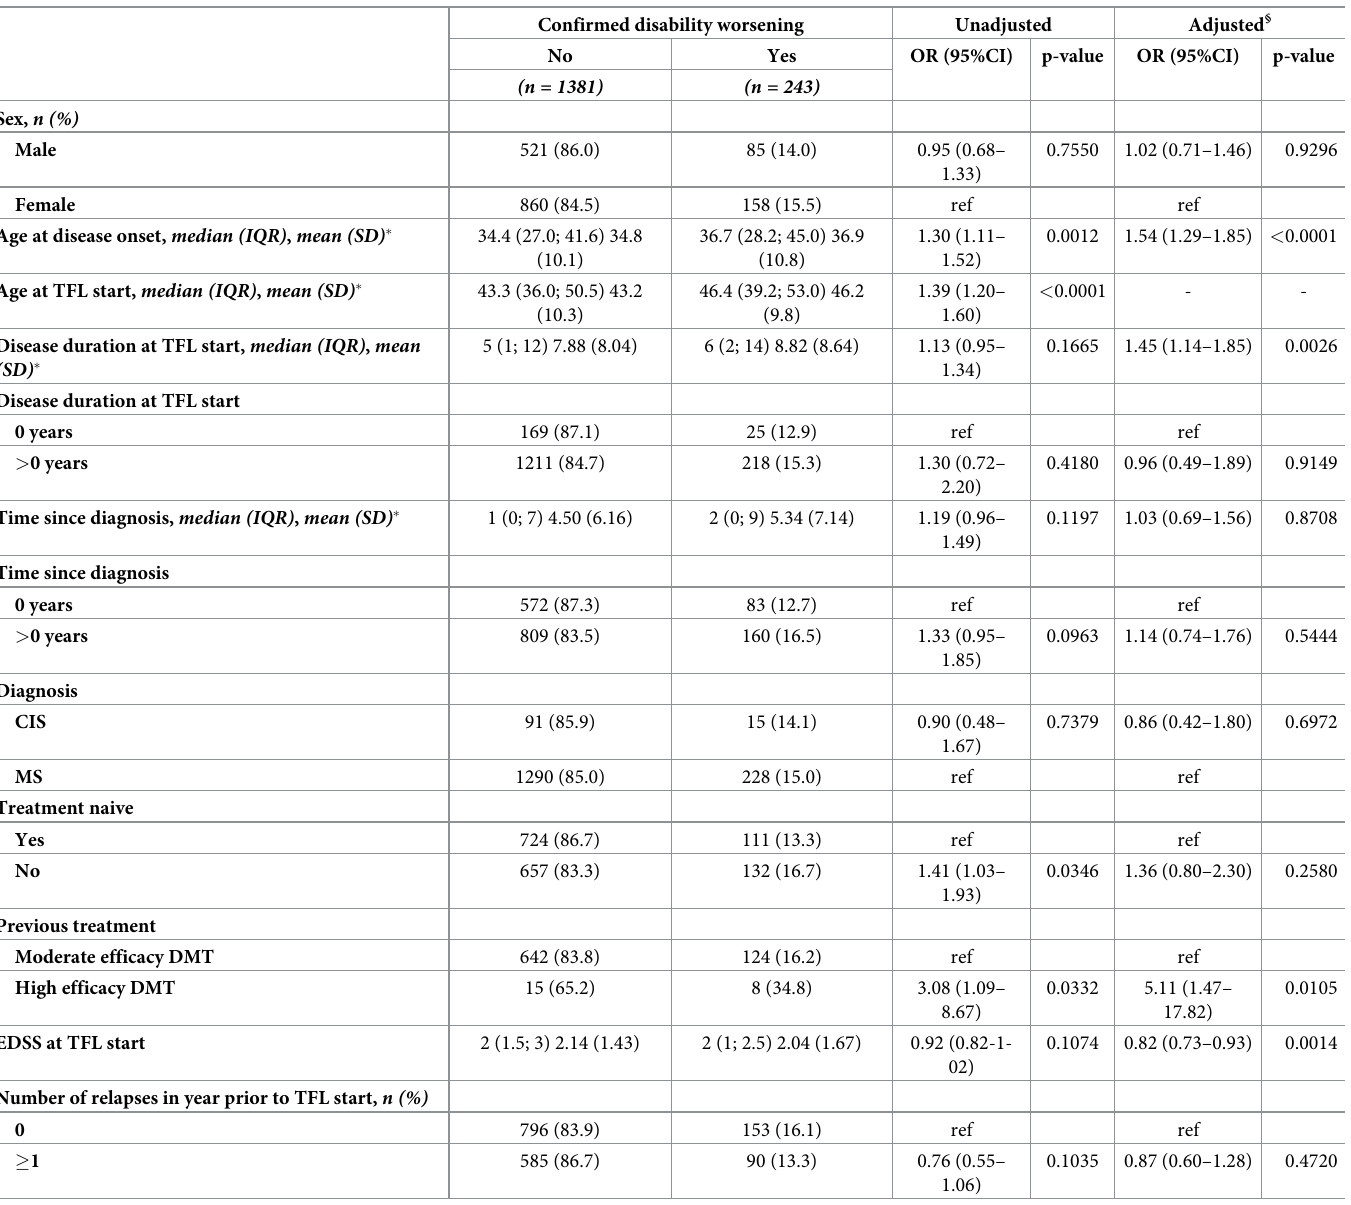
Table 3. Confirmed disability